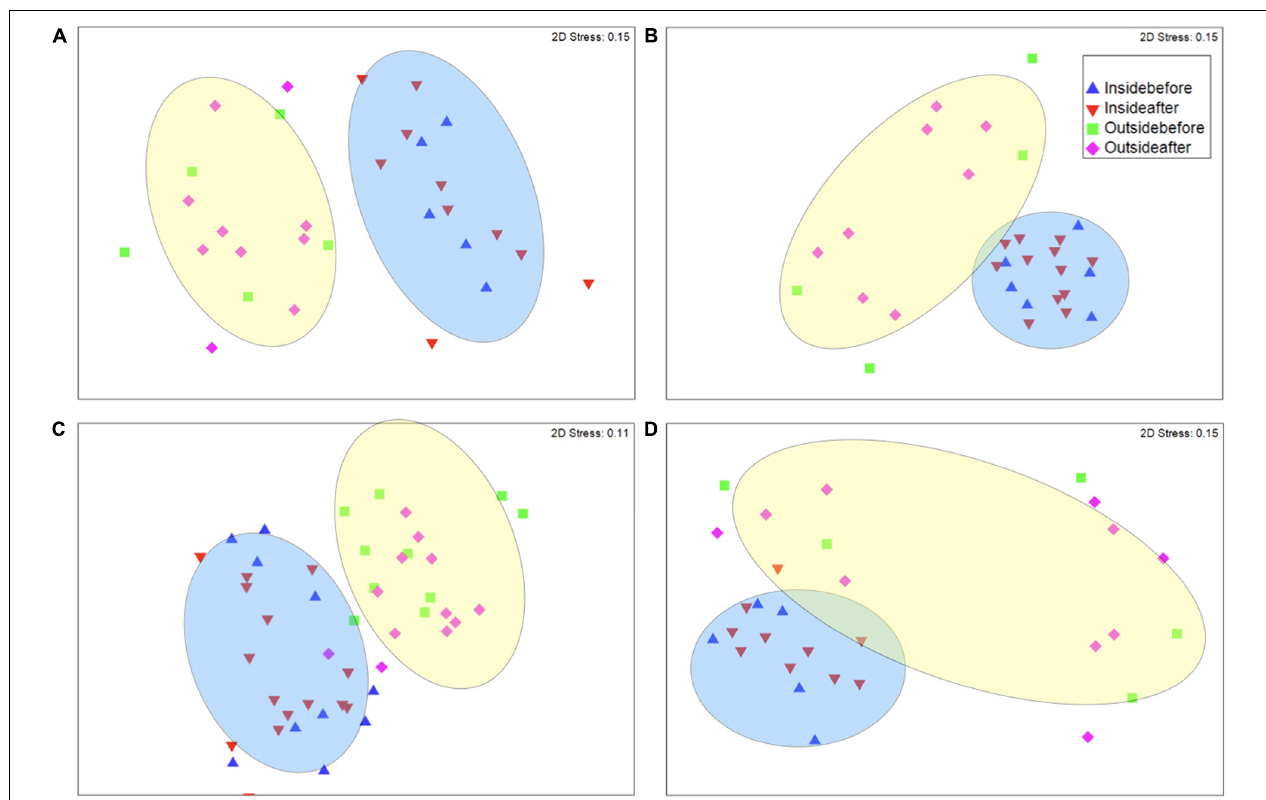
FIGURE 3 | Non-metric multidimensional scaling plot of fish species community structure similarities of (A) Lubang, (B) San Carlos City, (C) Bindoy, and (D) Looc. Triangles denote the community structure inside marine reserve [blue indicates before and red indicates after community-based management (CBM) implementation], and squares and diamonds outside of marine reserves, with squares indicating before, and diamonds indicating after CBM implementation. The ellipses indicate significant clusters ( P <